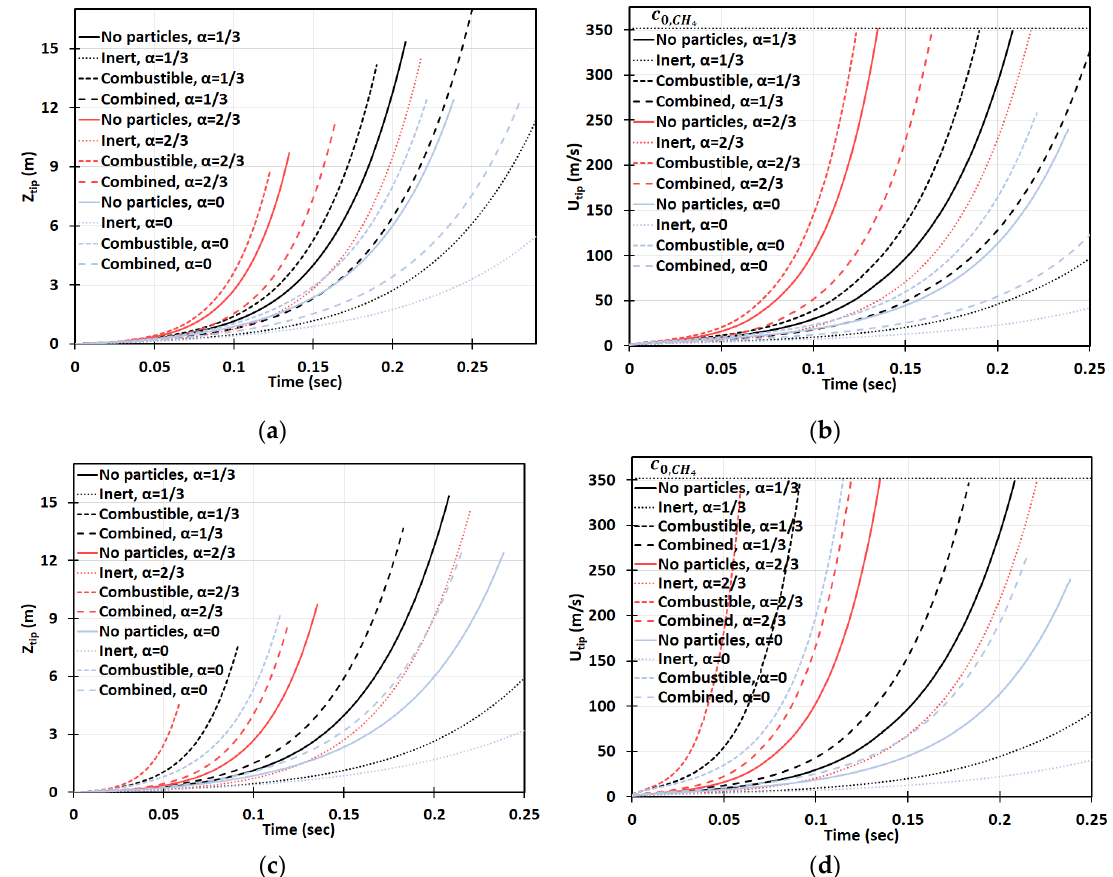
Figure 16. Time evolution of the flame tip position Z tip ( a , b ) and velocity U tip ( c , d ) in a 2D ( a , b ) and cylindrical-axisymmetric ( c , d ) geometries for lean CH 4 -air burning of φ = 0.7 with and without dust particles (combustible, inert, and combined) of particle radius r s = 10 µ m and concentration c s = 120 g/m 3 , for various blockage ratios, α =